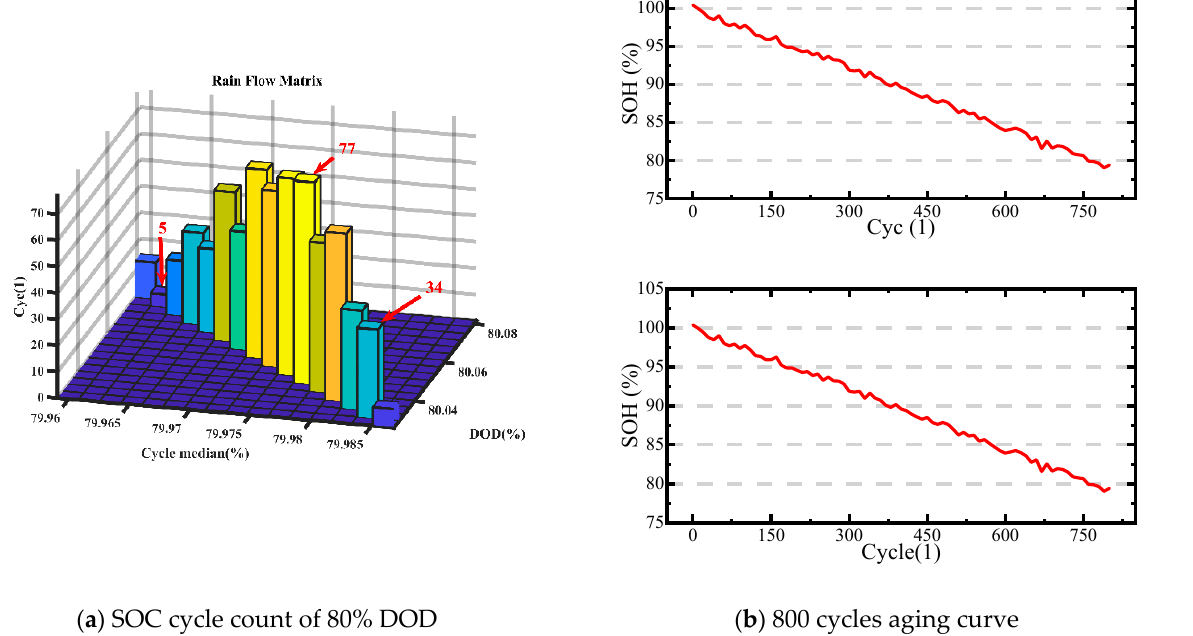
Figure 5. Life decay curve for 800 cycles at 80% discharge depths